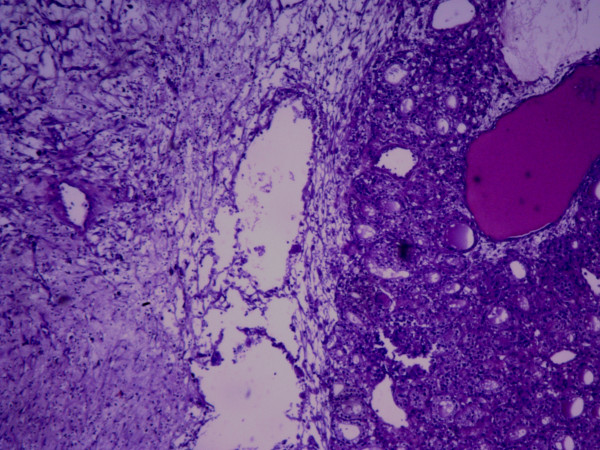
Short title of figure: Microscopic appearance of the resected tumor. Detailed legend: The tumor was initially diagnosed as granulosa cell tumor in frozen study but finally turned out to be Struma Ovarii in permanent study.